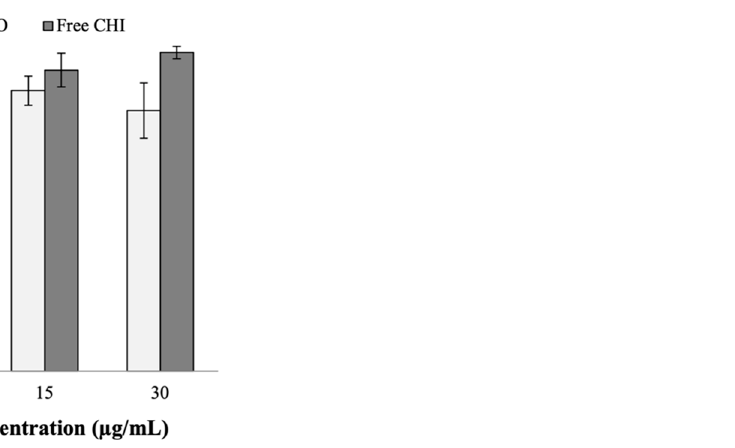
Figure A1. Cytotoxicity of the free CHI and dimethyl sulfoxide (DMSO) towards the A549 cells.